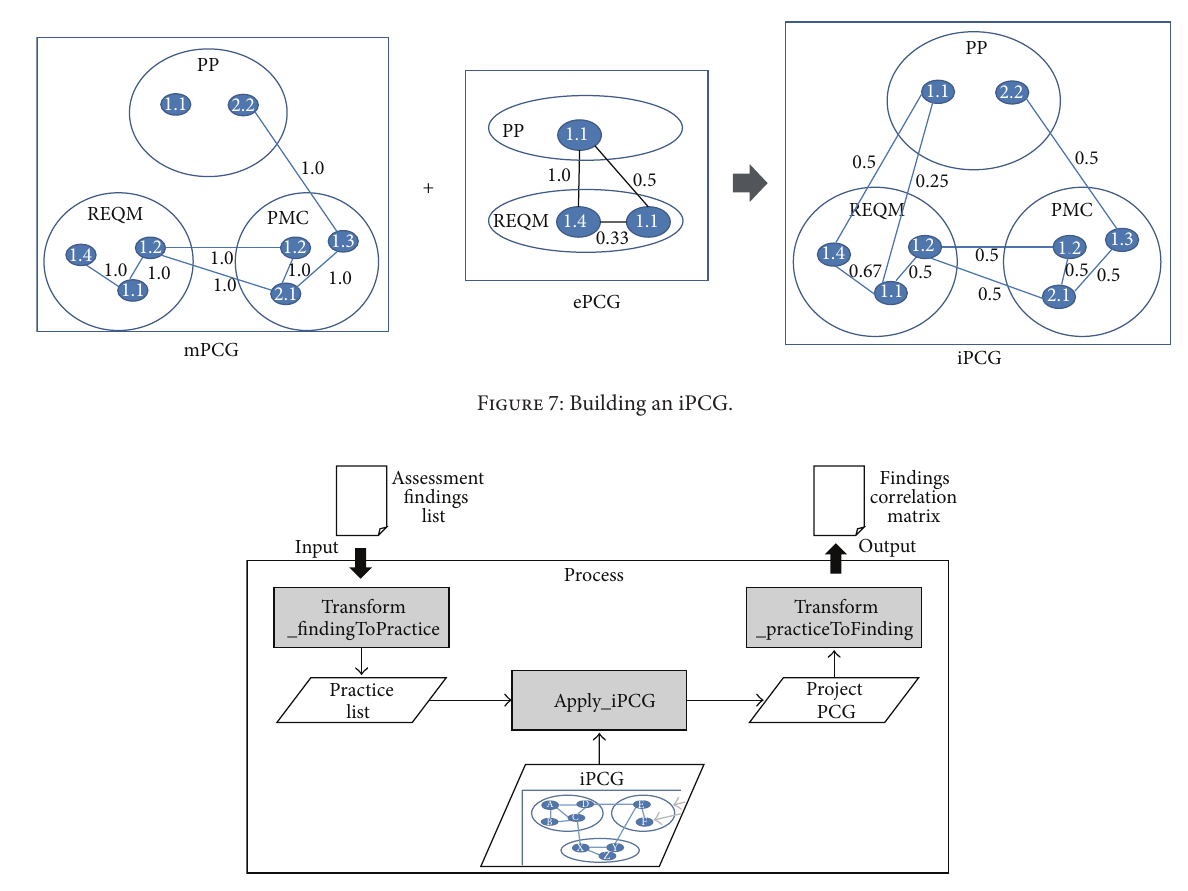
Figure 8: Application process of the correlation model.